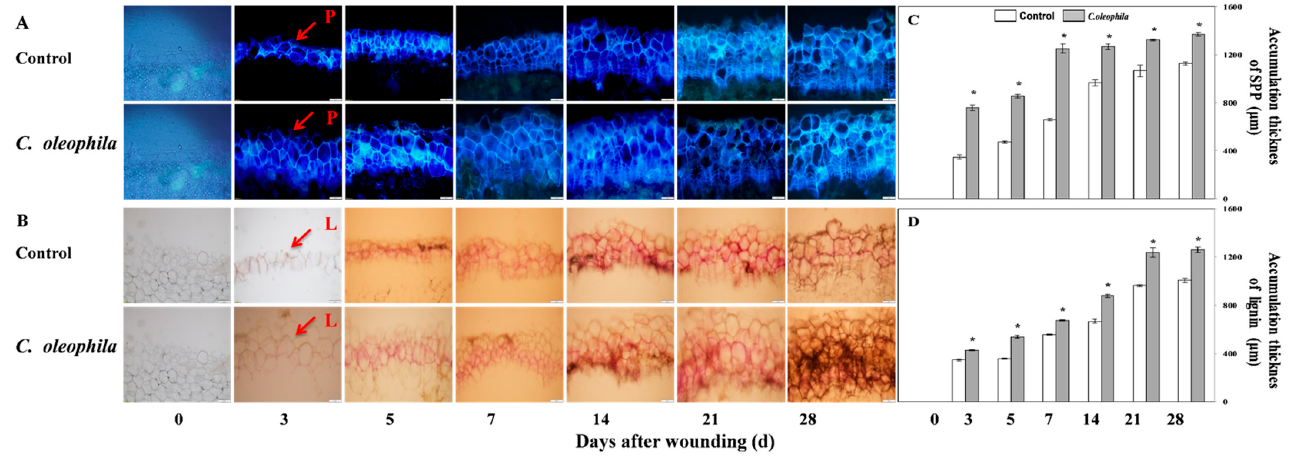
Figure 2. Effect of C. oleophila treatment on the accumulation of SPP ( A ) and lignin ( B ) and cell layers thickness of SPP ( C ) and lignin ( D ) at wounded sites of tubers during healing. Red arrows indicate SPP and lignin deposited in cell walls and are marked as “P” and “L”, respectively. Bars indicate standard error (±SE). Asterisks indicate significant difference ( p < 0.05).